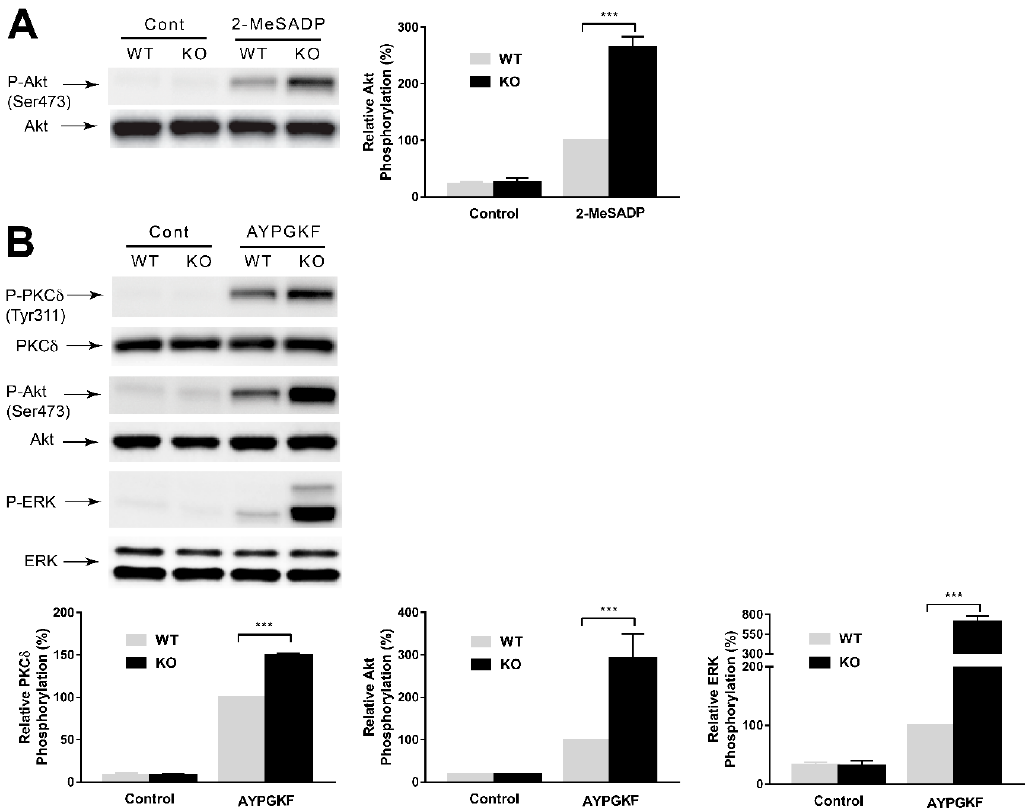
Figure 5. Potentiation of GPCR-mediated signaling events in GRK6-deficient platelets. Washed platelets from GRK6 − / − (KO) mice and GRK6 +/+ (WT) littermates were stimulated with ( A ) 50 nM 2-MeSADP and ( B ) 100 µ M AYPGKF for 2 min and probed with anti-phospho-PKC δ (Tyr 311 ), anti-phospho-Akt (Ser 473 ), anti-phospho-extracellular signal-related kinase (ERK), anti-Akt, anti-protein kinase C δ (PKC δ ), or anti-ERK antibodies by Western blotting. Blots are representative of three independent experiments and are presented as mean ± SE. ***, p < 0.005. Int. J. Mol. Sci. 2020 , 21 , 3932